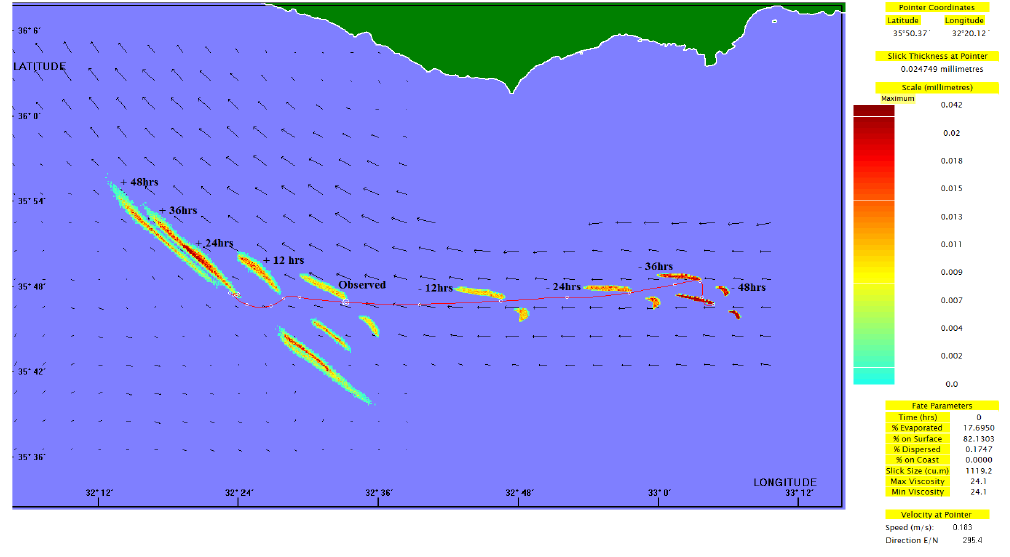
Fig. 5. Forecast (on the left) and hindcast positions (right) at intervals of 12h for the observed slick in the satellite image shown in Fig. 2a.